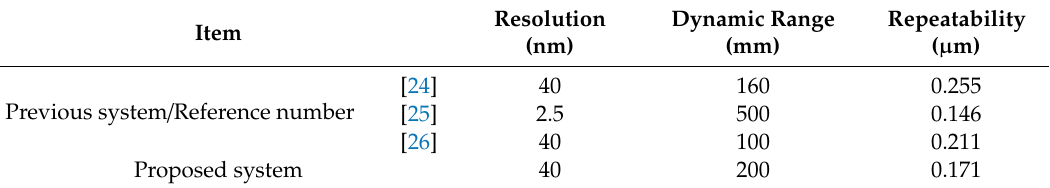
Table 3. Comparison results of the proposed system.